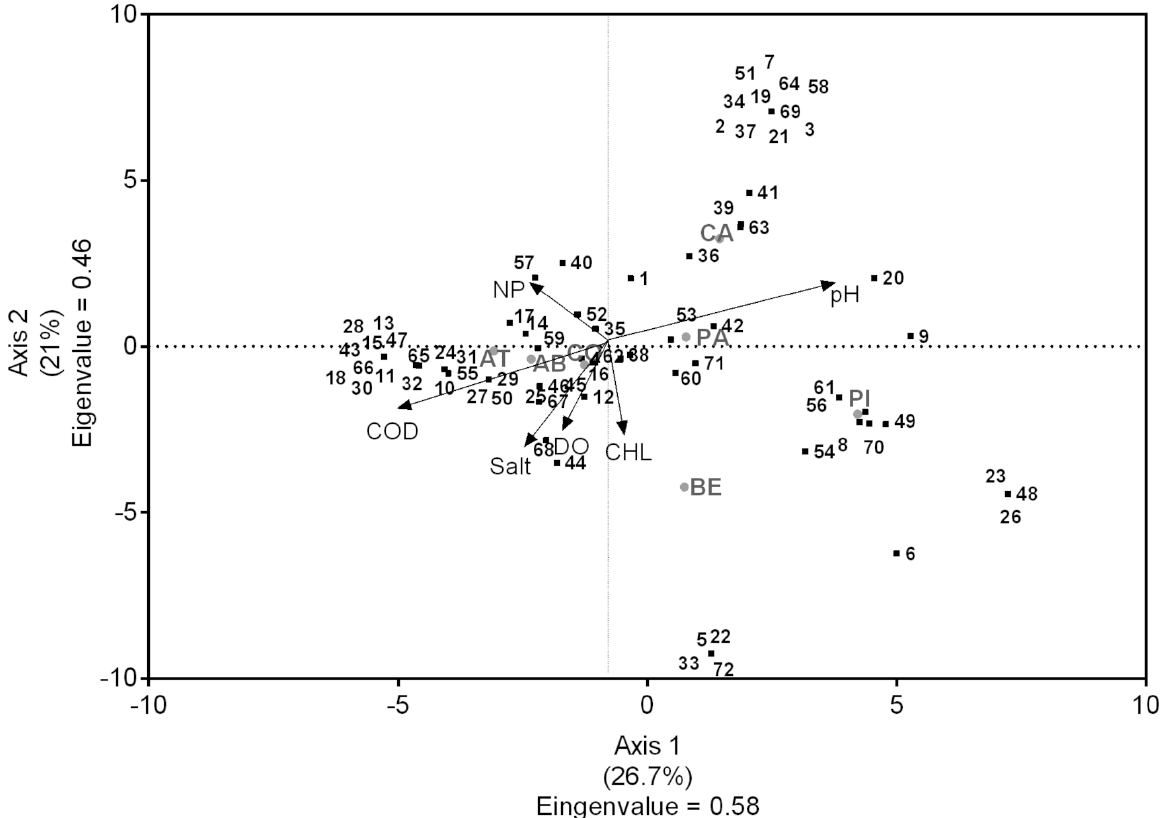
Figure 5. CCA diagram integrating abundance occurrence, physical and chemical variables, and studied environments. Letters represent environments: AT= Atoleiro; AB= Amarra-Boi; CO= Comprida; BE= Bezerra; PIT= Pitanga; PA= Paulista and CA= Cabiúnas. Physical and chemical variables were: pH; DOC= dissolved organic carbon; TP= total phosphorous; Salt= salinity; OD= dissolved oxygen; and CHL= chlorophyll biomass. Biotic variables are represented by numbers: 1= Ascomorpha ecaudis ; 2= Ascomorpha saltans ; 3= Asplanchna sieboldi ; 4= Bdeloidea; 5 = Brachionus plicatilis ; 6= Collotheca ornata ; 7= Conochilus coenobasis ; 8= Hexarthra intermedia ; 9= Hexarthra mira ; 10= Kellicottia sp . cf.; 11= Lecane boettgeri ; 12= Lecane bulla ; 13= Lecane curvicornis ; 14= Lecane leontina ; 15= Lecane luna ; 16= Lecane lunaris ; 17= Lecane signifera ; 18= Monommata dentate ; 19= Platyonus patulus ; 20= Polyarthra dolichoptera ; 21= Sinantherina sp.; 22= Synchaeta sp.; 23= Synchaeta tremula ; 24= Testudinela patina ; 25= Testudinela ohlei ; 26= Trichocerca pusilla ; 27= Trichocerca similis ; 28= Alona glabra ; 29= Leberis davidi ; 30= Coronatella poppei ; 31= Alonella clathratula ; 32= Alona dentifera ; 33= Anthalona verrucosa ; 34= Bosmina hagmanni ; 35= Bosminopsis deitersi ; 36= Ceriodaphnia cornuta ; 37= Chydorus sp.; 38= Chydorus sphaericus ; 39= Diaphanosoma birgei ; 40= Diaphanosoma brevireme ; 41= Diaphanosoma spinulosum ; 42= Disparalona leptorhynca ; 43= Dunhevedia odontoplax ; 44= Ephemeroporus barroisi ; 45= Ephemeroporus hybridus ; 46= Ilyocryptus spinifer ; 47= Macrothrix laticornis ; 48= Macrothrix paulensis ; 49= Moina minuta ; 50= Scapholeberis armata ; 51= Simocephalus latirostris ; 52= Calanoida juvenile; 53= Cyclopoid juvenile; 54= Harpacticoida juvenile; 55= Microcyclops anceps; 56= Harpaticod Copepod; 57= Diaptomus azureus ; 58= Microcyclops sp.; 59= Calanoid Nauplii; 60= Cyclopoid Nauplii; 61= Harpacticoid Nauplii; 62= Notodiaptomus cearensis ; 63= Notodiaptomus sp.; 64= Mesocyclops longisetus ; 65= Arcella discoides ; 66= Arcella megastoma ; 67= Centropyxis aculeate ; 68= Centropyxis discoides ; 69= Colonial Ciliate; 70= Difflugia corona ; 71= Difflugia pseudogramen ; 72= Protocurcubitella